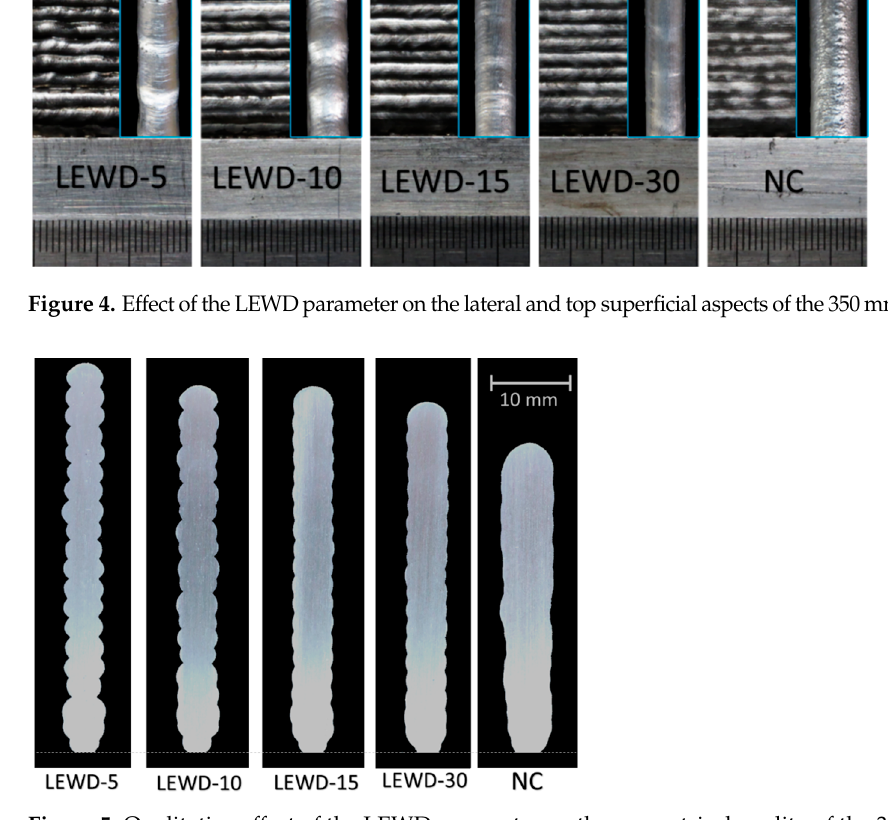
Figure 4. Effect of the LEWD parameter on the lateral and top superficial aspects of the 350 mm- long walls.